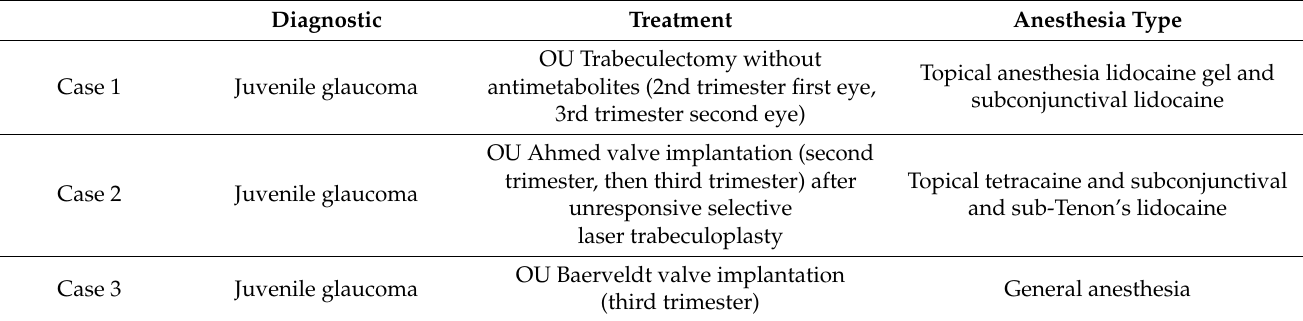
Table 5. Surgical management in glaucoma with success in control of intraocular pressure